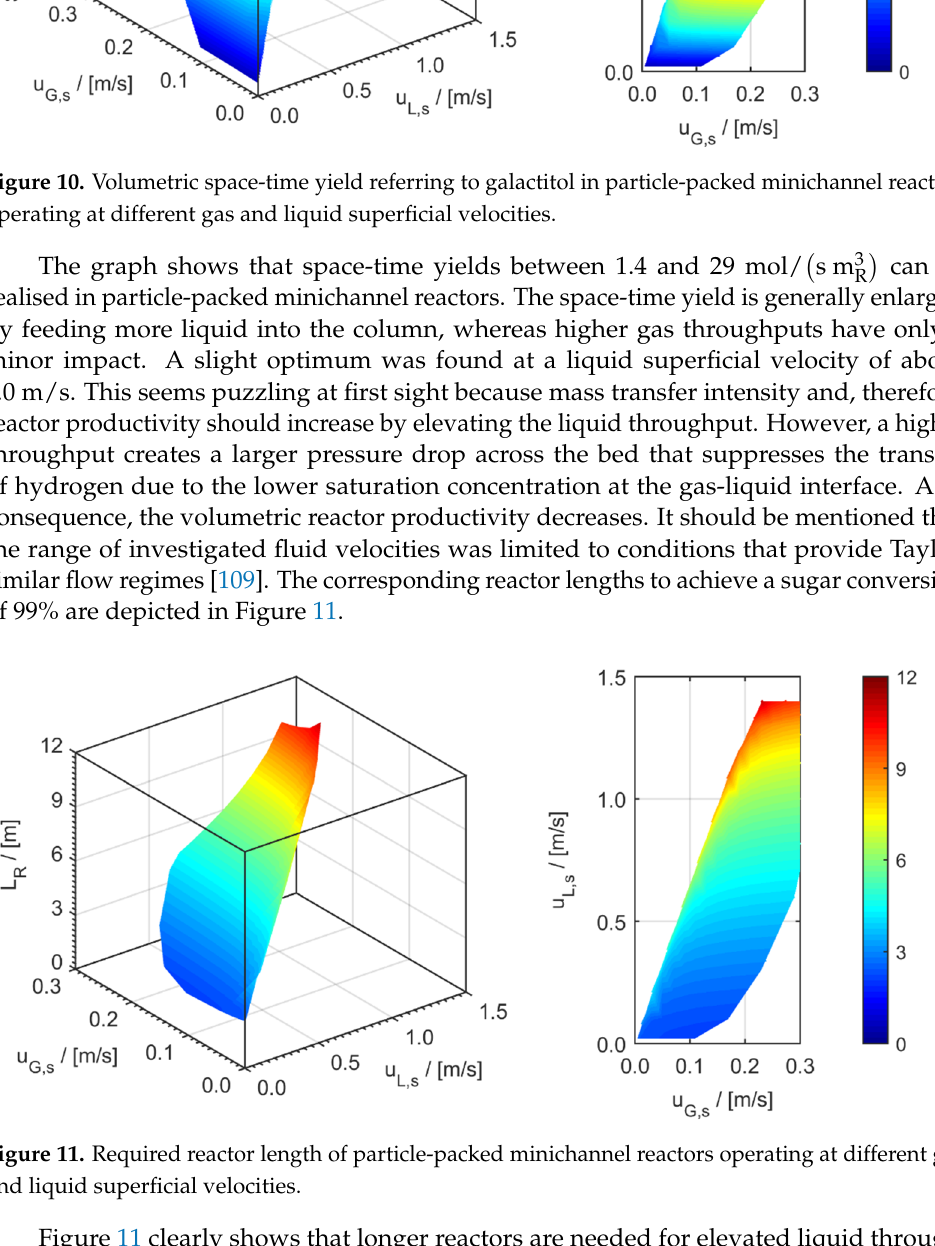
Figure 10. Volumetric space-time yield referring to galactitol in particle-packed minichannel reac- tors operating at different gas and liquid superficial velocities.